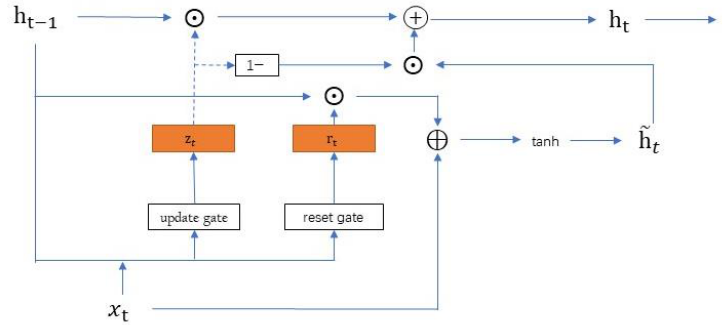
Figure 5. GRU unit Figure 5. GRU unit structure.